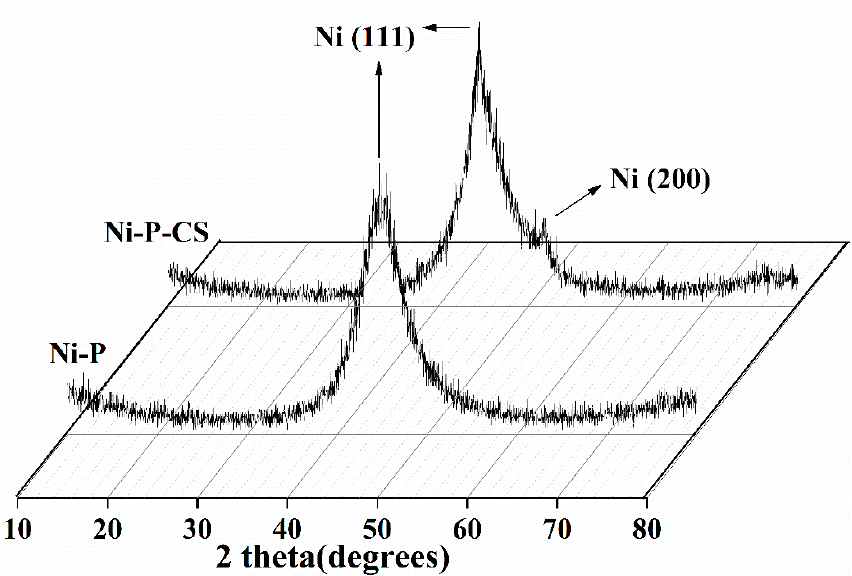
Figure 3. XRD of the Ni-P and Ni-P-CS composite coatings.